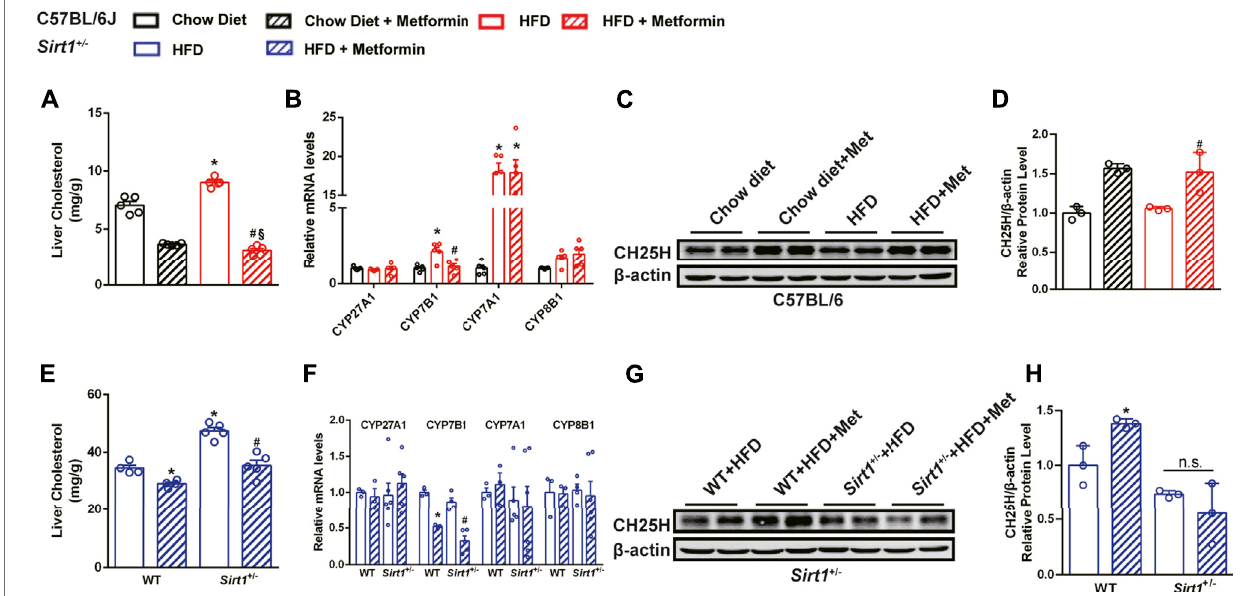
FIGURE 6 | SIRT1 de fi ciency impairs the effect of metformin on regulating cholesterol catabolism. Metformin reduced (A) hepatic cholesterol content in DIO mice ( p ＜ 0.05). (B) The relative mRNA level of CYP7B1 in the liver of DIO mice was reduced by metformin ( p ＜ 0.05). (C,D) The relative protein expression of CH25H was signi fi cantly upregulated ( p ＜ 0.05) but that of CYP7B1 was unaffected ( p ＞ 0.05) by metformin in the liver of DIO mice. Although (E) metformin also reduced hepatic cholesterol content ( p ＜ 0.05) and (F) downregulated the mRNA expression of CYP7B1 in Sirt1 +/ − mice ( p ＜ 0.05), (G,H) the protein levels of CH25H were unaffected by metformin in the liver of Sirt11 +/ − mice ( p ＞ 0.05). In C57BL/6J mice, * p ＜ 0.05, HFD group vs Chow diet group, # p ＜ 0.05, HFD + Metformin vs. HFD group. In Sirt1 +/ − mice, * p ＜ 0.05, WT + HFD + Metformin or Sirt1 +/ − + HFD vs. WT + HFD group, # p ＜ 0.05, Sirt1 +/ − + HFD + Metformin vs. Sirt1 +/ − + HFD group.